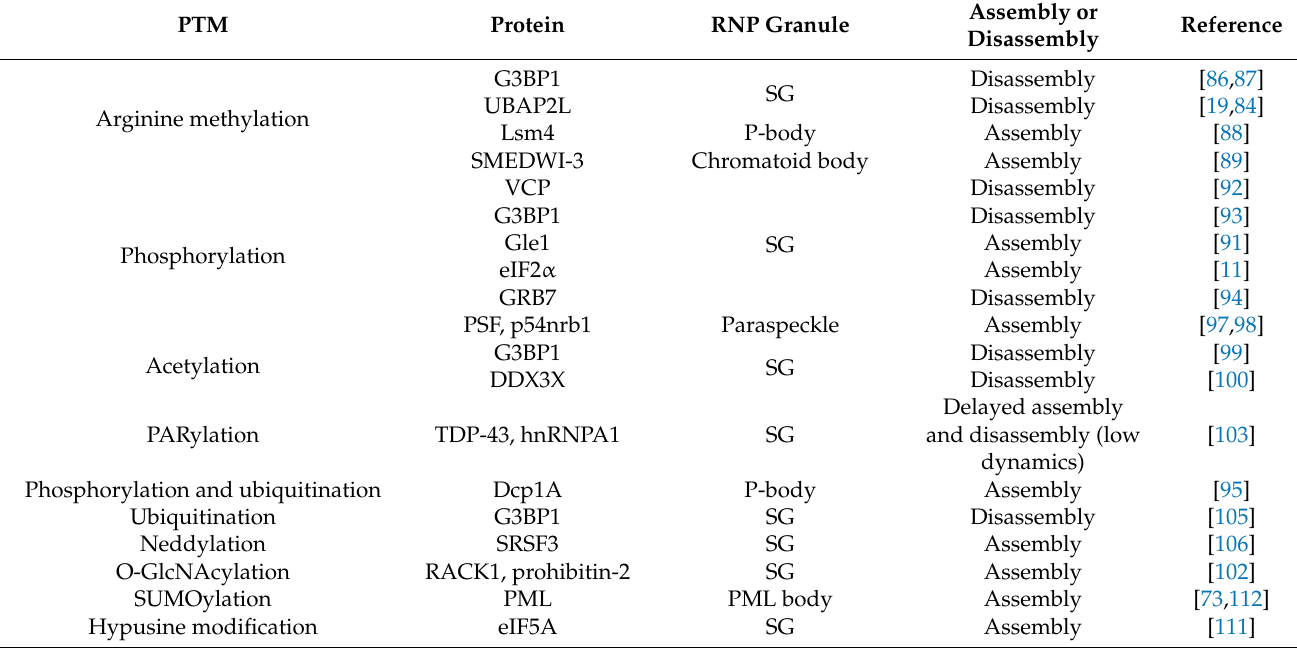
Table 1. PTMs regulating physiological ribonucleoprotein (RNP) granule